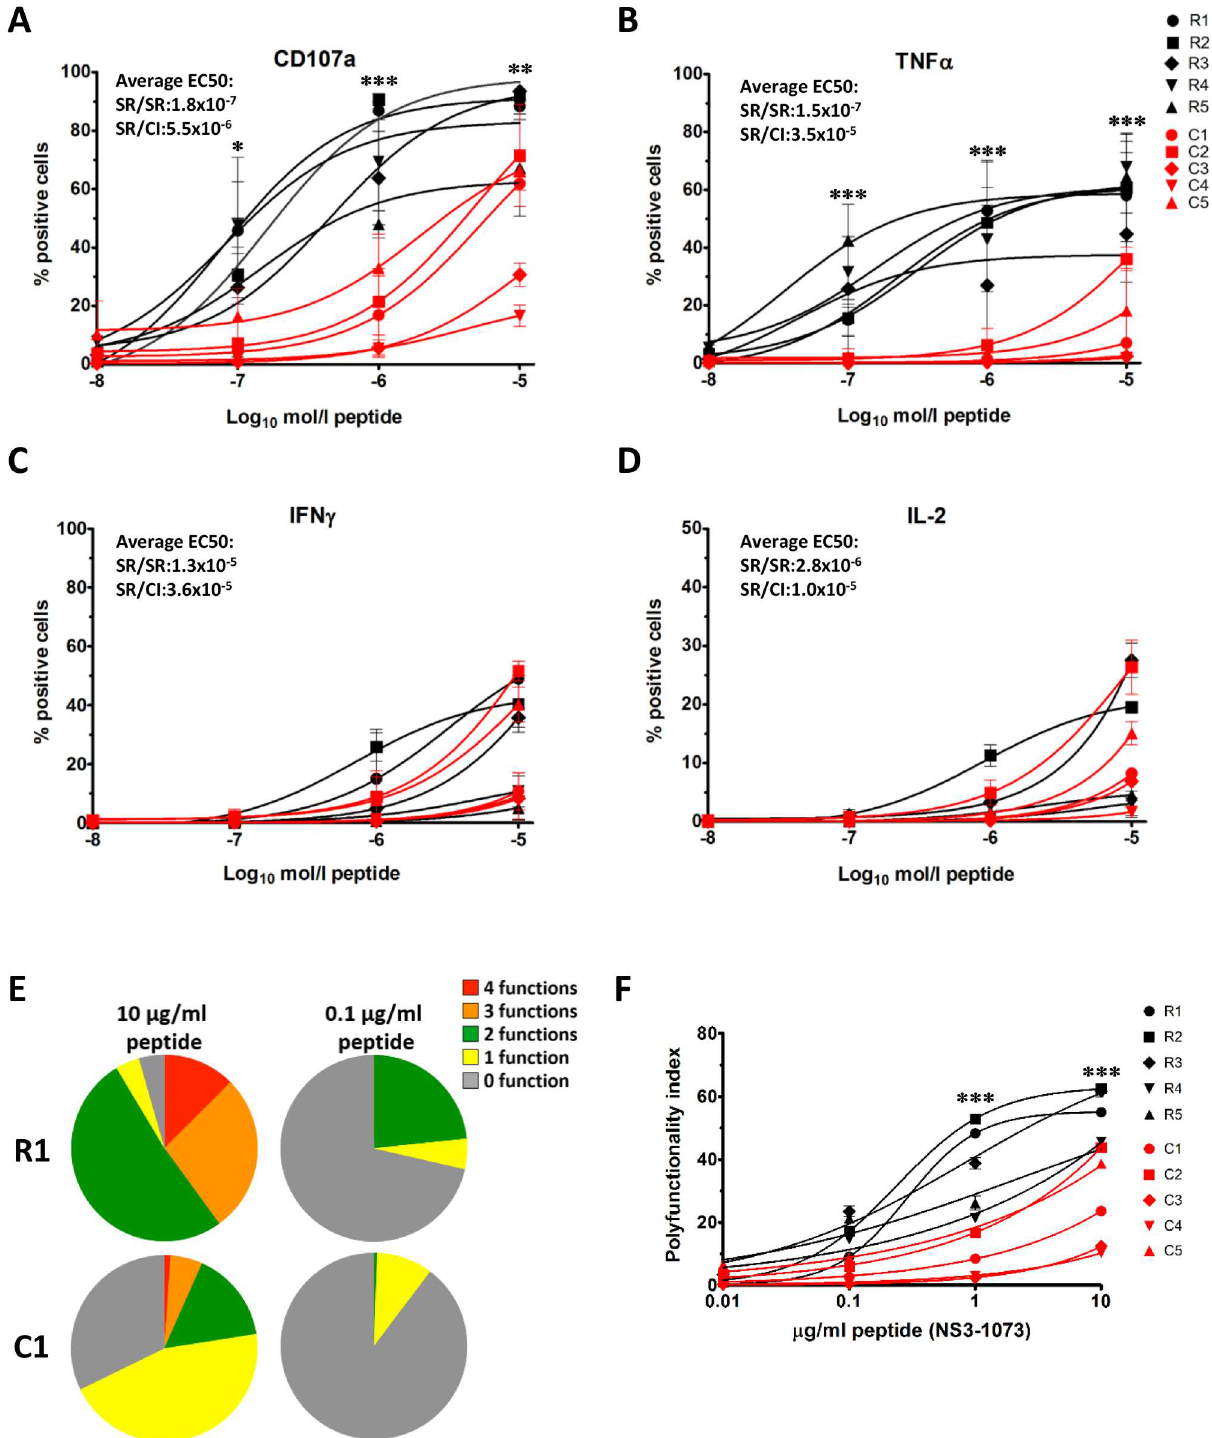
Fig 7. Higher functional avidity and polyfunctionality for cell lines from resolvers SR/SR compared to cell lines from chronic SR/ CI. CD8 T cell lines were stimulatedwith autologousBLCLs prepulsed with increasing concentrations of the cognate peptide(NS3-1073)for 6h. Surface and intracellular stainingwas then performed as describedin Materials and Methodsto examinefunctionalityby flow cytometry. Booleangating and analysisusing SPICE software was used to assess polyfunctionality profile for each clone established from patient SR/ SR-1 (Cell lines R1 to R5) or from patient SR/CI-2 (Cell lines C1 to C5). (A-D) Functionality curves for (A) CD107a, (B) TNF α , (C) IFN γ and